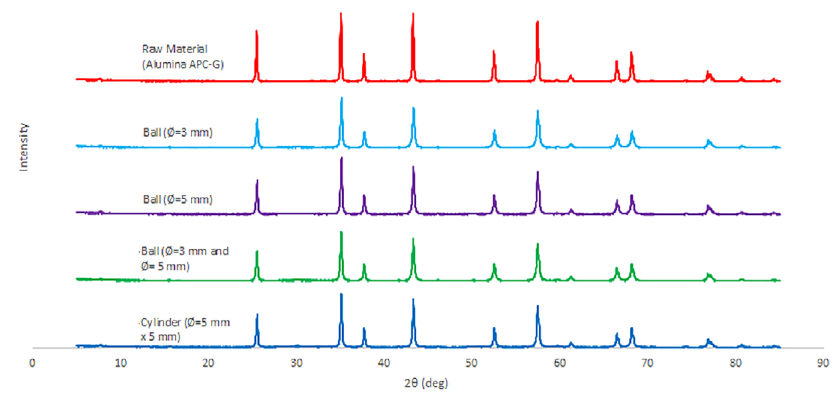
Figure 5. X-ray powder diffraction of the raw material and